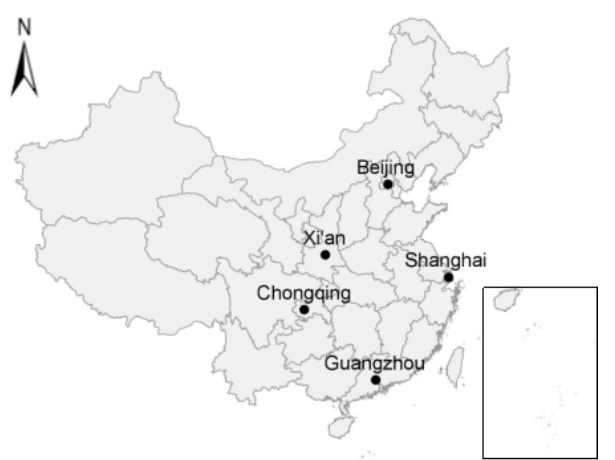
Figure 1. Location map of China and the five cities.